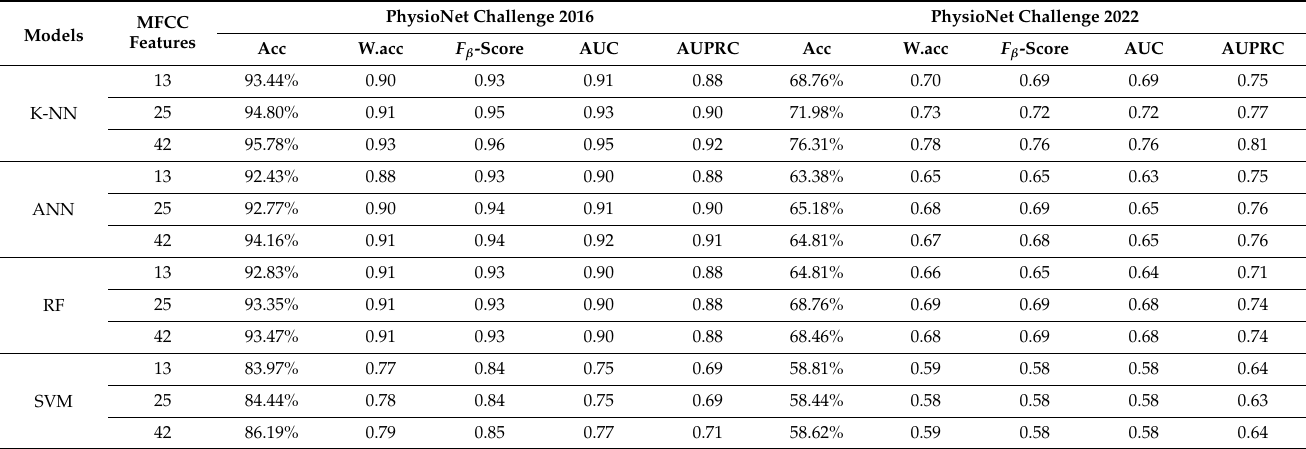
Table 1. The classification performance using several classifier